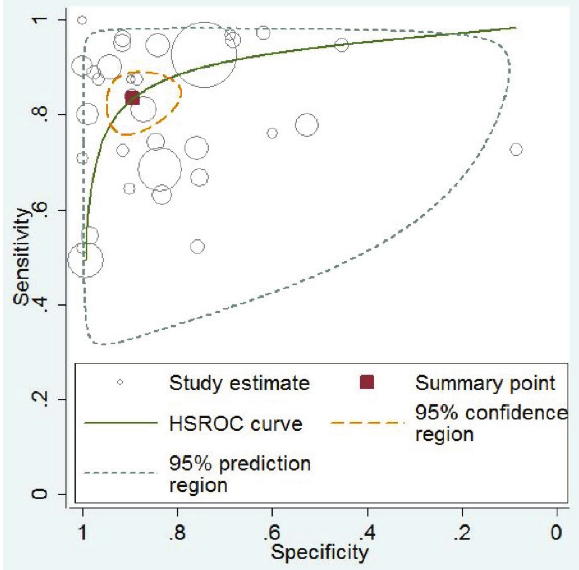
Figure 8: The AUC of the SROC for 1,3-β-D-glucan in diagnosis of invasive fungal infection